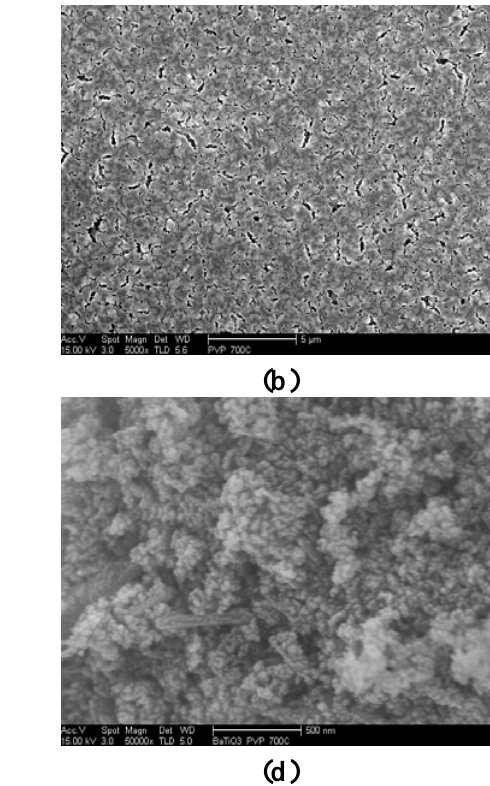
Figure 6. SEM micrographs of BaTiO